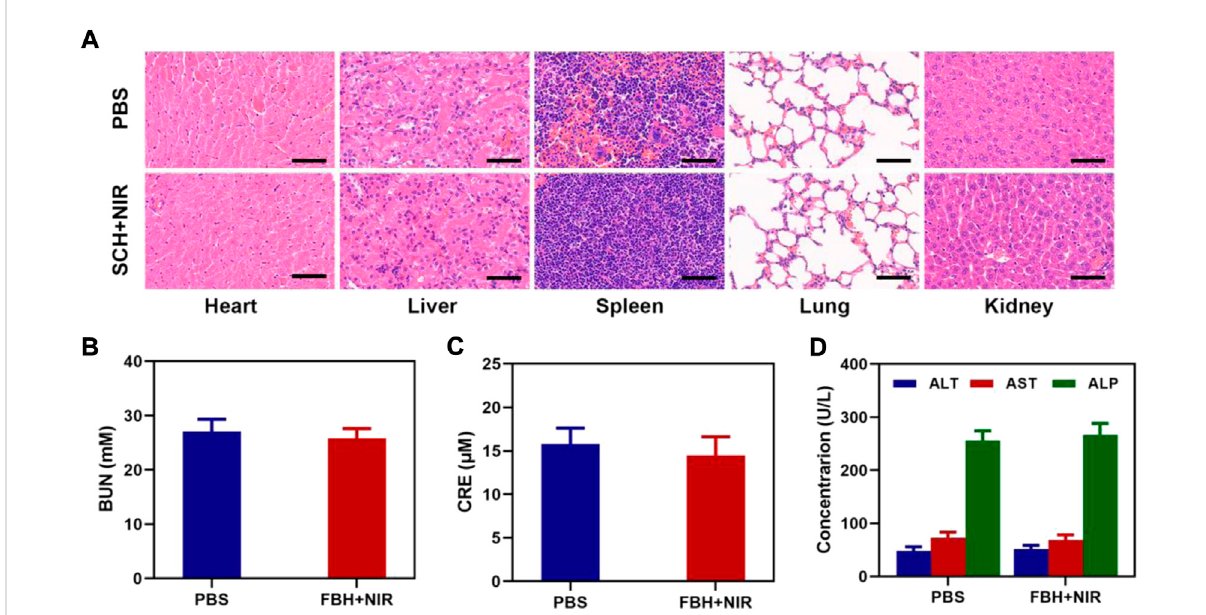
FIGURE 4 (A) Results of H&E-stained images for the mice ’ s major organs, including the heart, lung, liver, kidneys, and spleen, after exposure to various therapies 16 days after the injection. Scale bars: 100 µm. (B) Kidney function markers: BUN, (C) CRE, and (D) liver function indicators: ALT, AST, and ALP following different